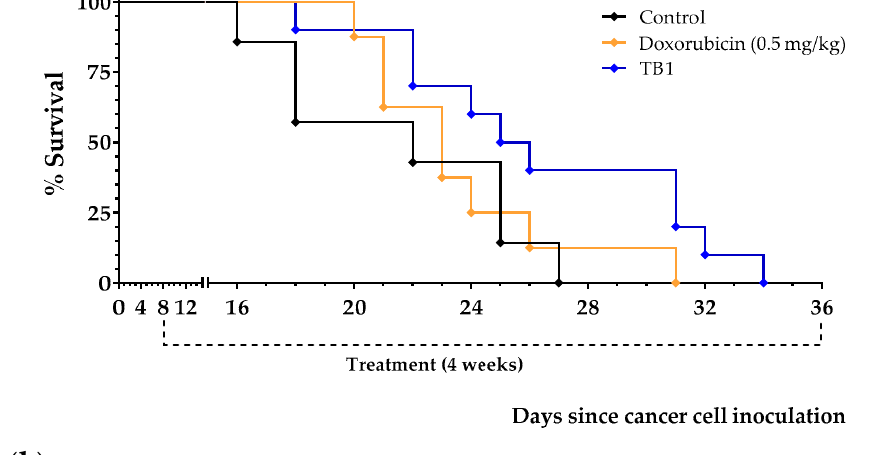
Table 3. Survival of mice with metastatic TNBC treated with diet TB1 or doxorubicin. Treatment n